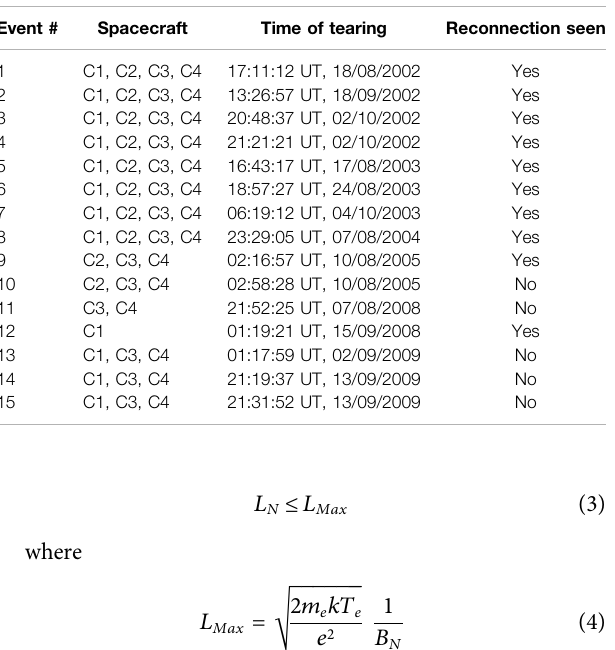
TABLE 1 | Times of the 15 tearing events, along with the spacecraft which detected the tearing distributions and the subsequent magnetic reconnection